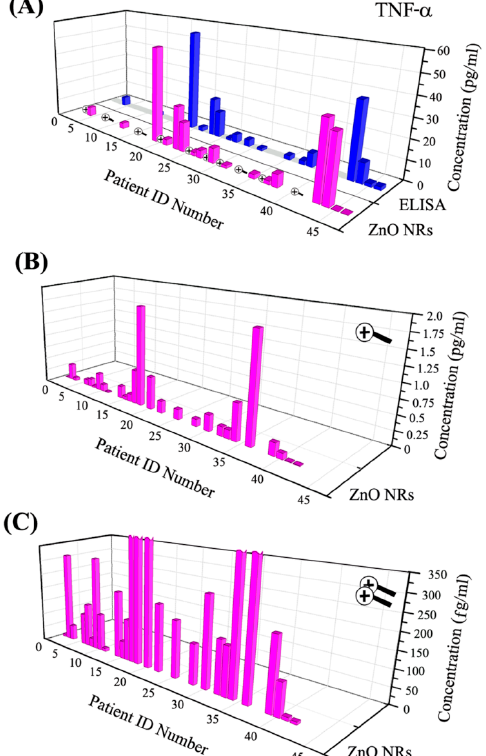
Figure 9. ( A ) The 3D bar graphs display the TNF- α concentrations in ICU patient urine samples measured by the ELISA- and ZnO NRs-based platforms for comparison. The grey regions in the ELISA row correspond to missing concentration data, indicating that the TNF- α levels in the samples were below the ELISA DL of 5.5 pg/mL. In contrast, ZnO NRs were able to measure the TNF- α concentrations of all 46 patients. The magnifier signs inserted in the ZnO NRs row correspond to the patients that belong to the grey area of the ELISA-based assay, and the bar graphs of these patients are shown separately in ( B , C ) for clarity; ( B , C ) The zoomed-in 3D bar graphs are the missing TNF- α concentrations that were revealed by the ZnO NRs-based assay. The upper limits of the vertical ranges in ( B , C ) are adjusted to 2 pg/mL and 350 fg/mL, respectively, in order to show the variations in the TNF- α concentrations between patients more clearly. The truncated bars indicate that their TNF- α concentrations exceed the upper limit of the 3D graph. Reproduced with permission from Ref. [87] Copyright (2016) Royal Society of Chemistry.